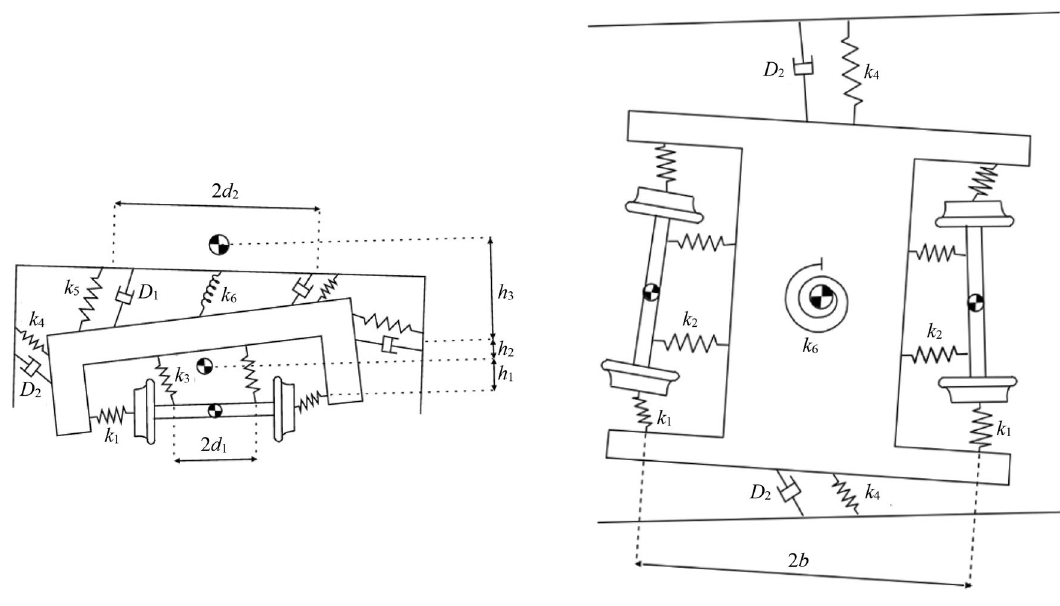
Fig. 1 The Cooperrider bogie